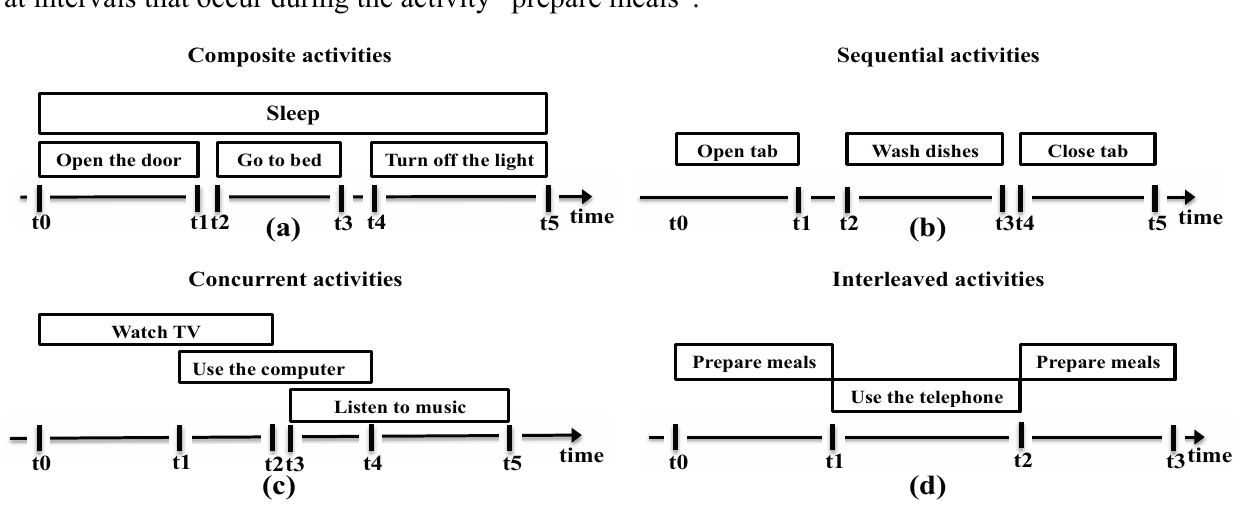
Figure 2. Diagrams showing different relationships between activities: ( a ) composite activities; ( b ) sequential activities; ( c ) concurrent activities; ( d ) interleaved